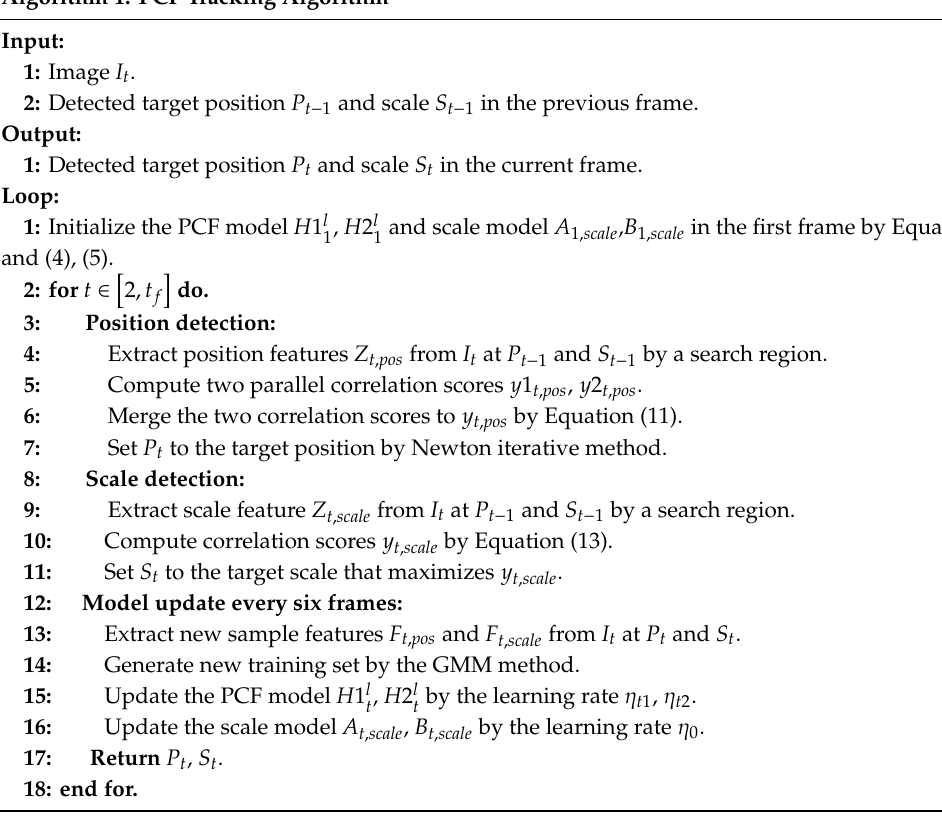
Algorithm 1. PCF Tracking